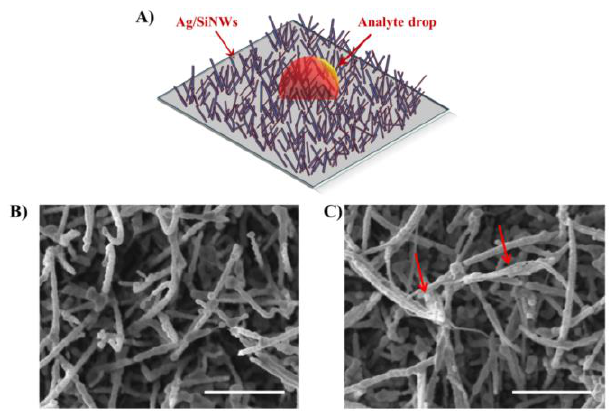
Figure 1. A schematic representing the analyte drop onto the array of Ag-covered silicon nanowires (Ag/SiNWs) ( A ). SEM images of the Ag/SiNWs outside ( B ) and inside ( C ) the dried droplet of the aqueous solution containing adenine. Scale bar 1 μm.